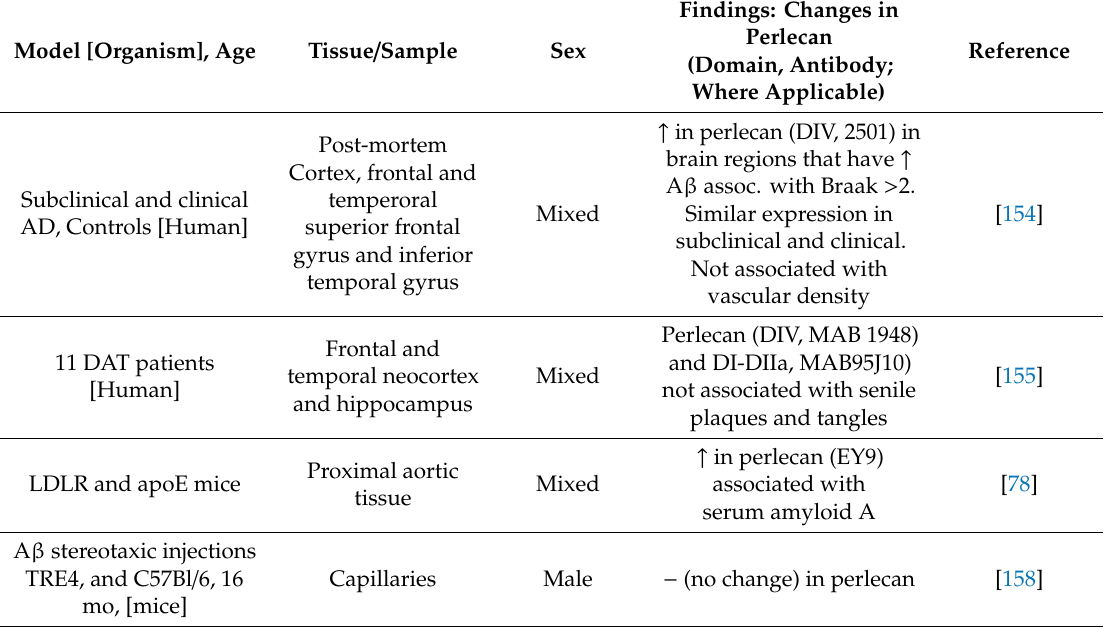
Table 3. Amyloid and